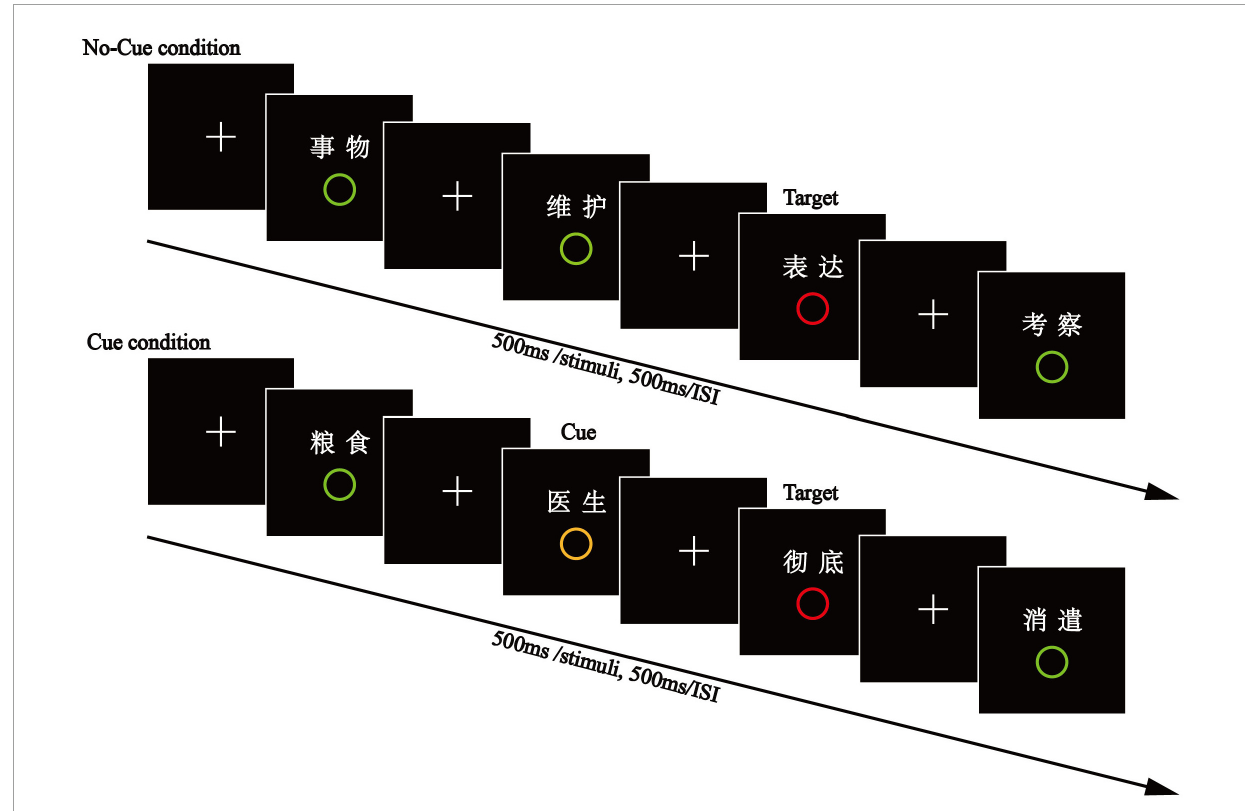
FIGURE1 The encoding phase of Experiment 1. In each trial, a word and circle (red, yellow, or green) appeared simultaneously at the center of the screen for 100 ms. Then, the circle was removed and the word shown continuously for another 400 ms. Participants read the words and rapidly pressed the space bar key when they detected a target red circle below the word.